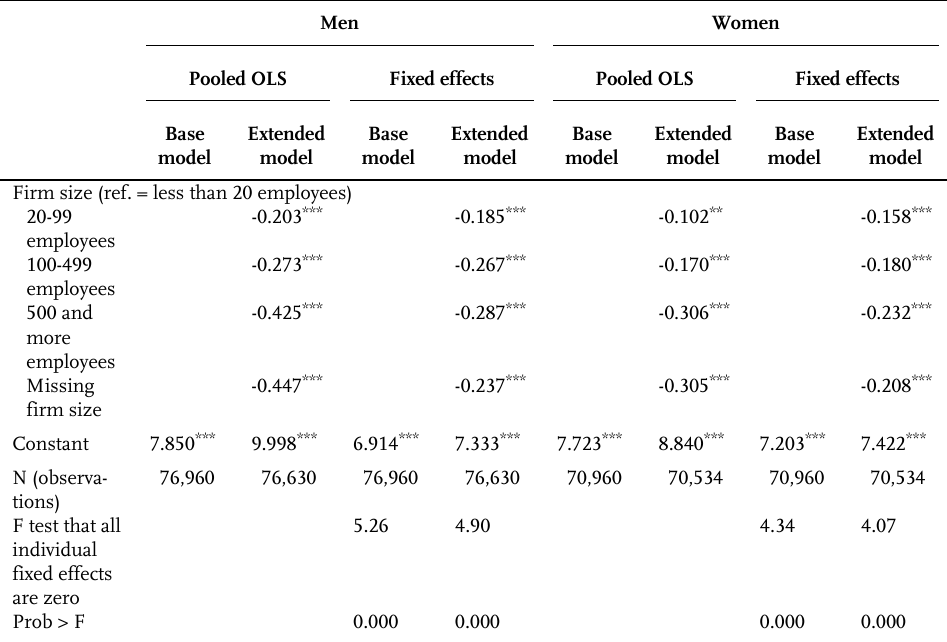
Table A.3 : Employment types and WLB (full models)